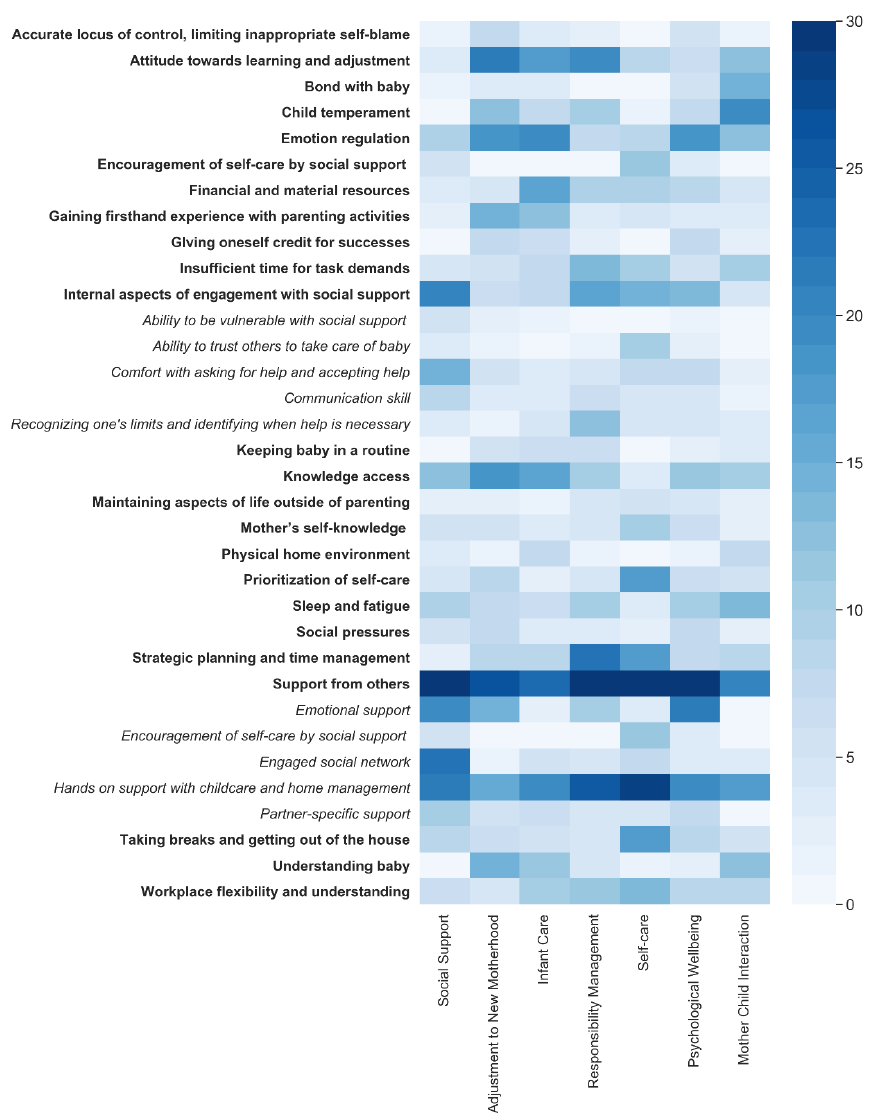
Figure 2. Heat map of factors across domains of functioning.